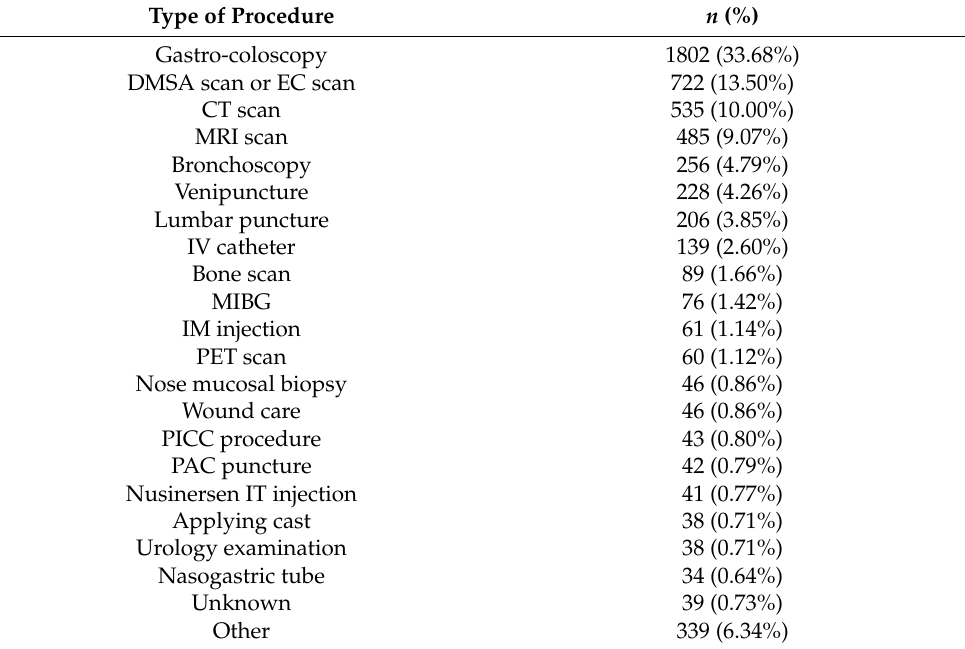
Table 4. Summary of the 5350 procedures assisted by